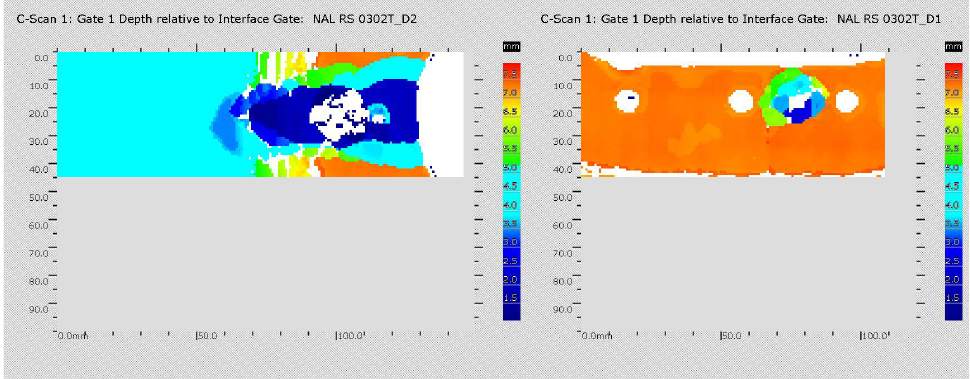
Figure 14. Ultrasonic scan of damaged areas in panel